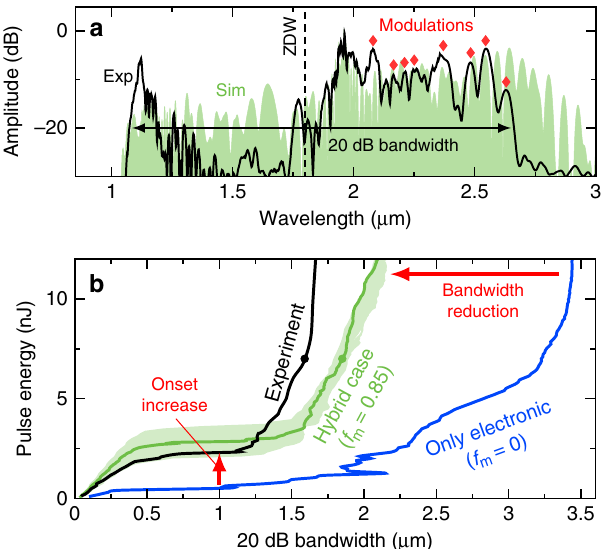
Fig. 6 Indications for hybrid soliton dynamics. a Measured (exp) and simulated single-shot (sim) spectra at the output of a CS 2 /silica LiCOF ( fi bre length: 7 cm, core diameter: 4.7 μ m). The red diamonds mark a few locations of spectral fringes. ZDW zero-dispersion wavelength. b Measured and simulated bandwidth at 20 dB spectral contrast for increasing input energy in comparison to an equivalent fi bre with entirely instantaneous response ( f m = 0). The circles label the positions of the spectra at 7 nJ shown in a . The light green area denotes simulations incorporating deviations of the non-instantaneous nonlinear response model and the pulse duration leading to f m = 0.85 ± 0.04 and γ = 0.28 ± 0.06 m − 1 W −